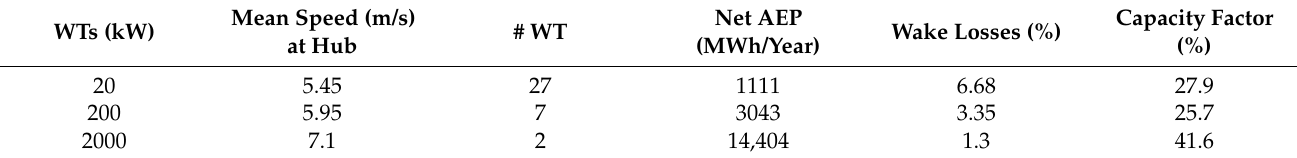
Table 3. Pantelleria wind technical potential.